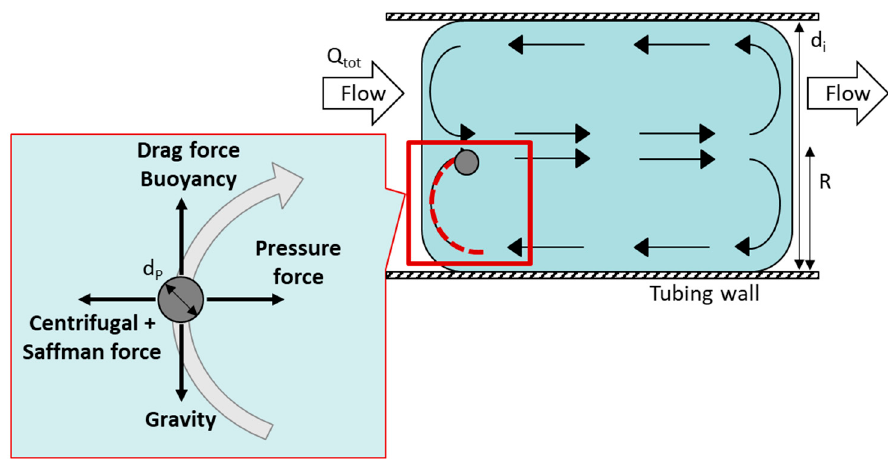
Figure 5. Schematic representation of relevant forces acting on a single particle at the moving on the vortex at the rear end of the slug for radial and vertical force balances.